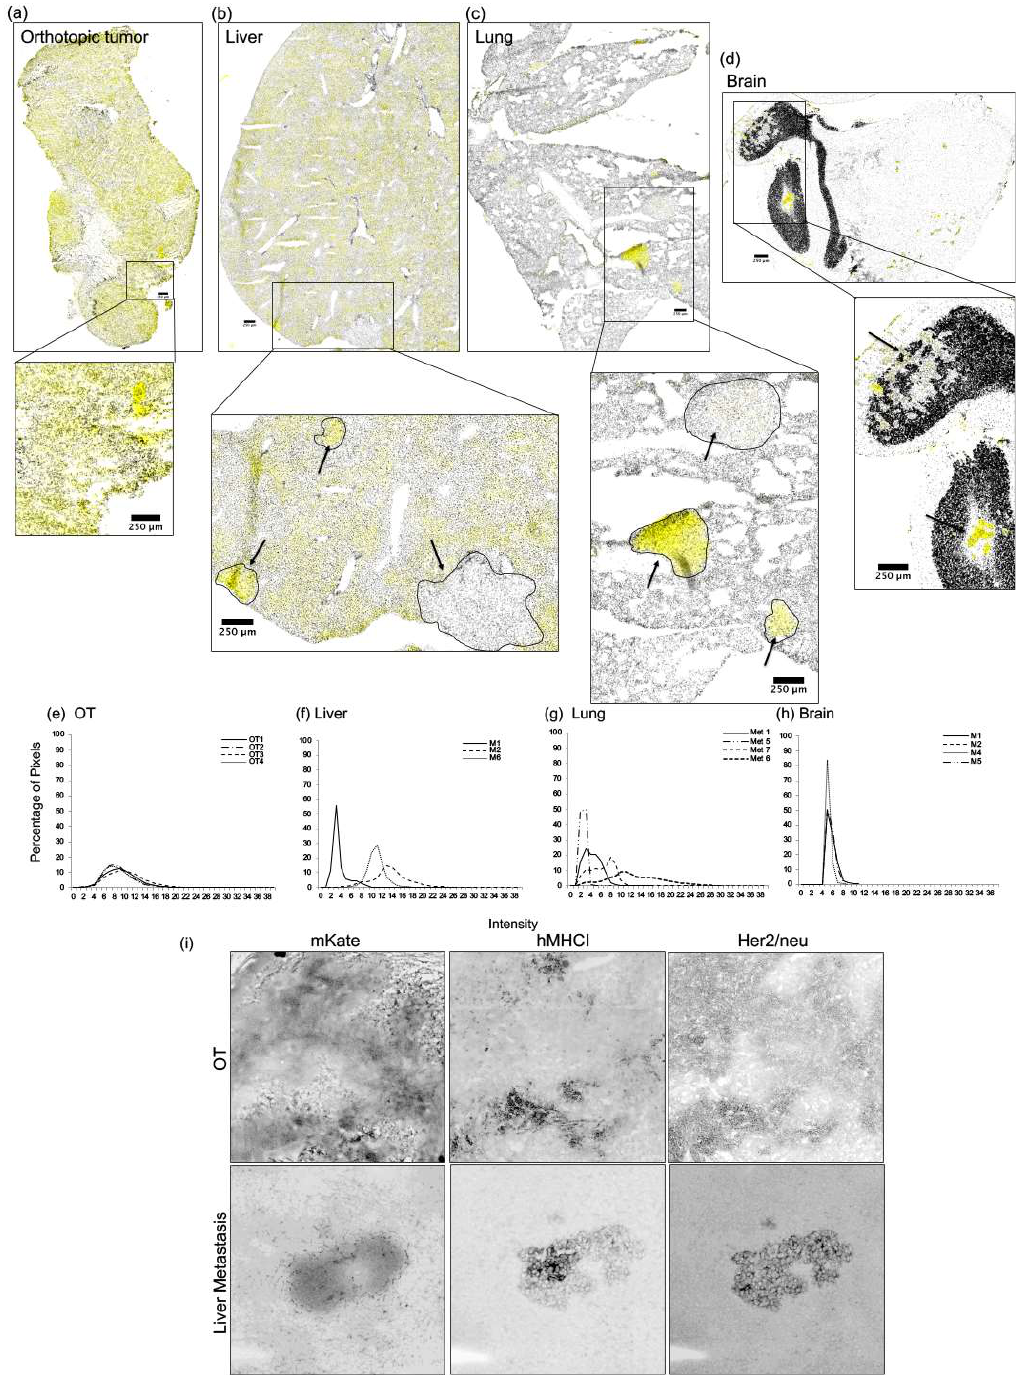
Figure 2. mKate, Her2/neu, and Hoechst nuclear dye were used to identify metastatic lesions in organ tissues subject